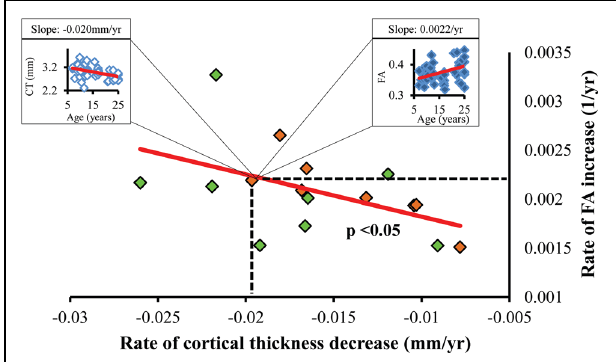
FIGURE 5 | Statistically significant ( p < 0.05) linear relationship between the regional CT decrease rate ( x -axis) and corresponding WM FA increase rate ( y -axis). Each dot represents the CT decrease rate and corresponding WM FA increase rate of a left (green dots) or right (orange dots) frontal gyrus. As an example, a dot representing the right pars orbitalis region can be expanded to an age-dependent scatter plot of CT (left box) and that of corresponding WM FA (right